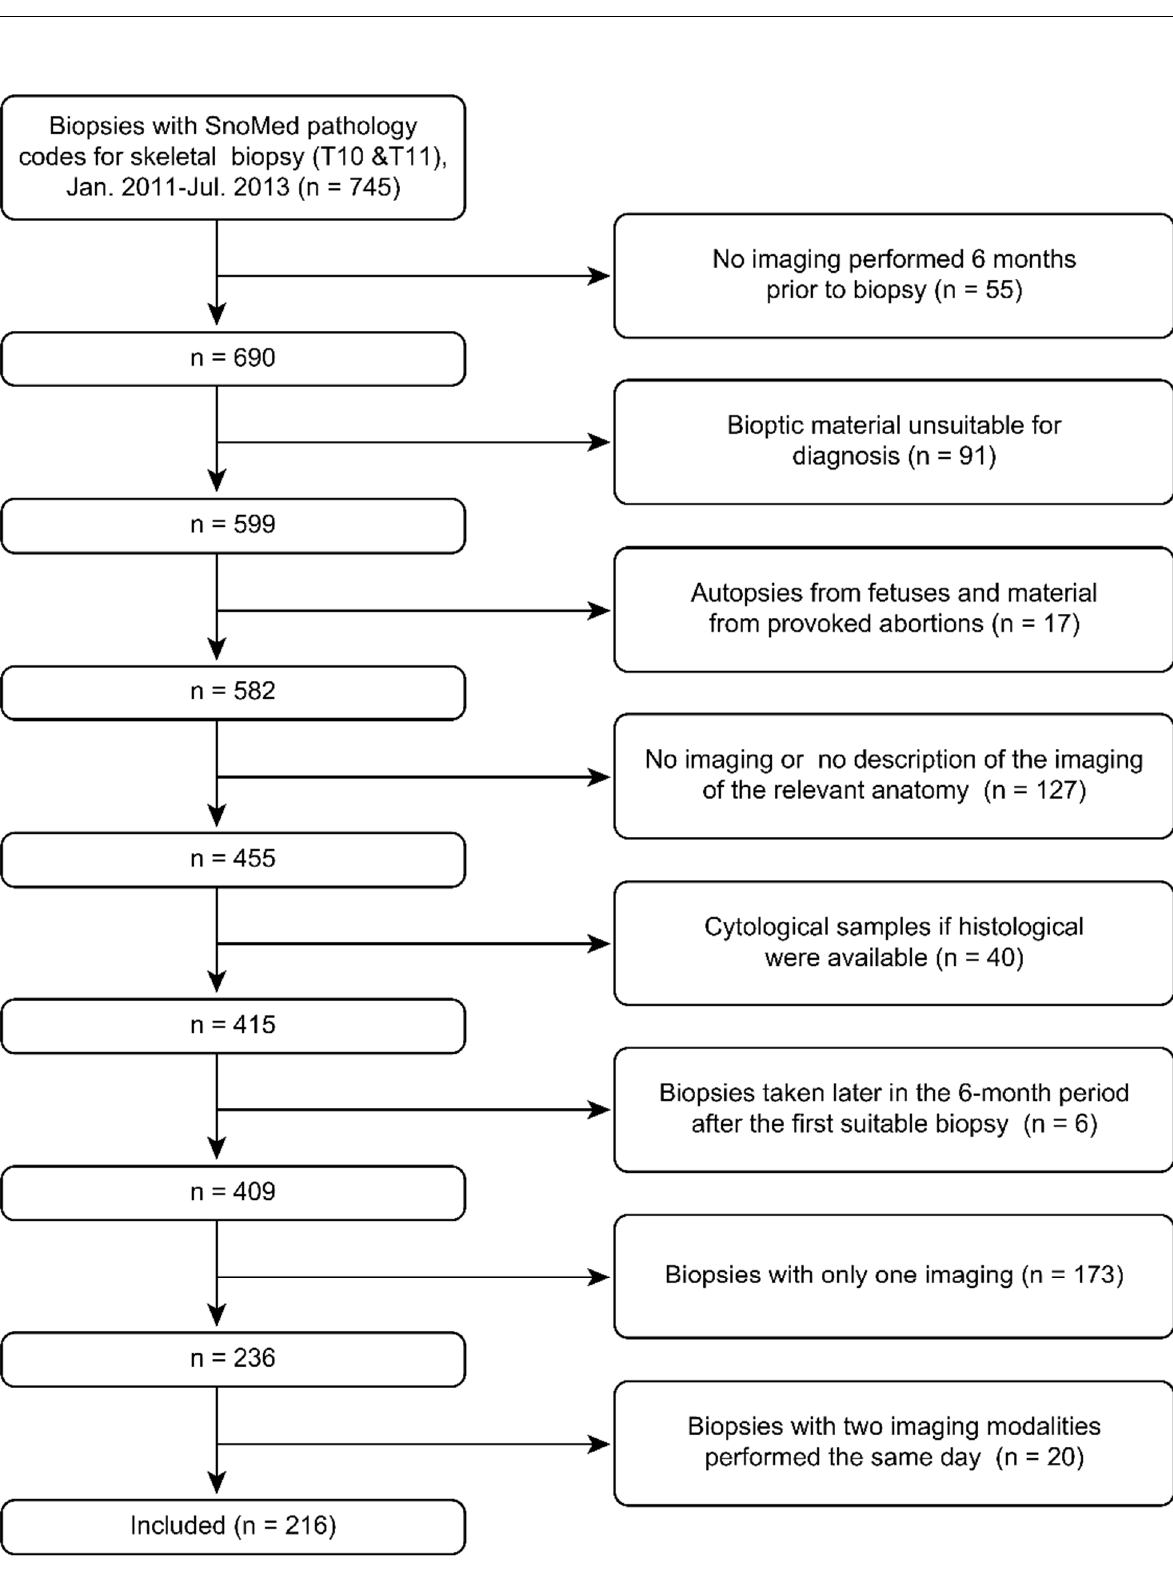
Figure 1. Flow chart of study